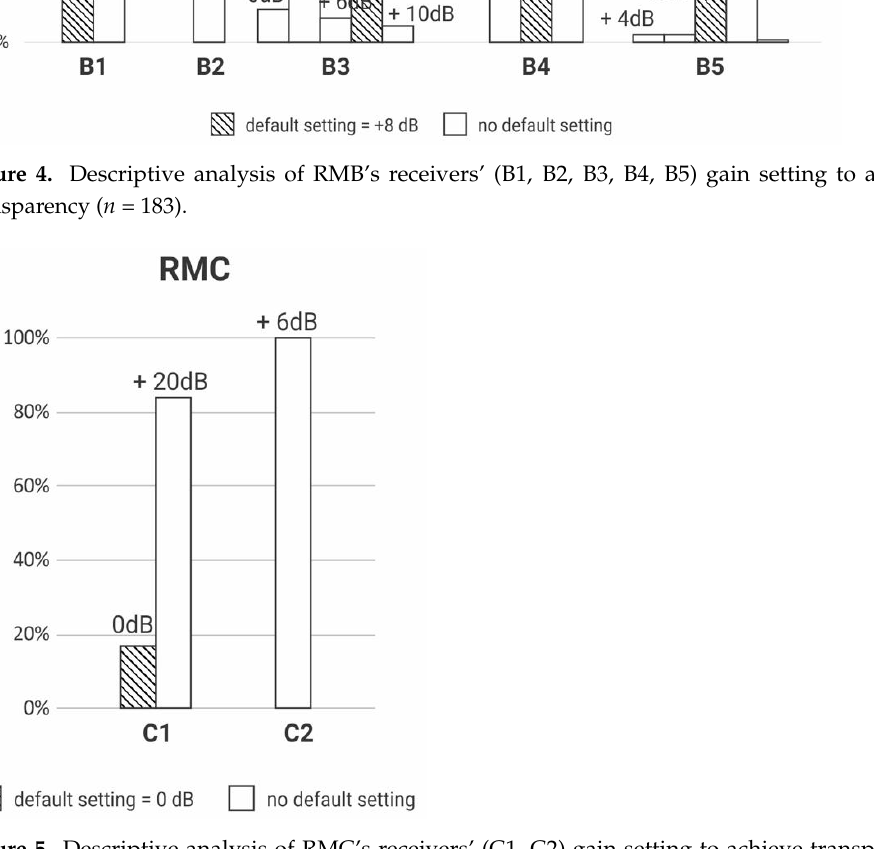
Table 1. Analysis of the association between the default setting variable and the degree of hearing loss (HL), transmit- ter/receiver brand, type of receiver, and hearing aid (HA).